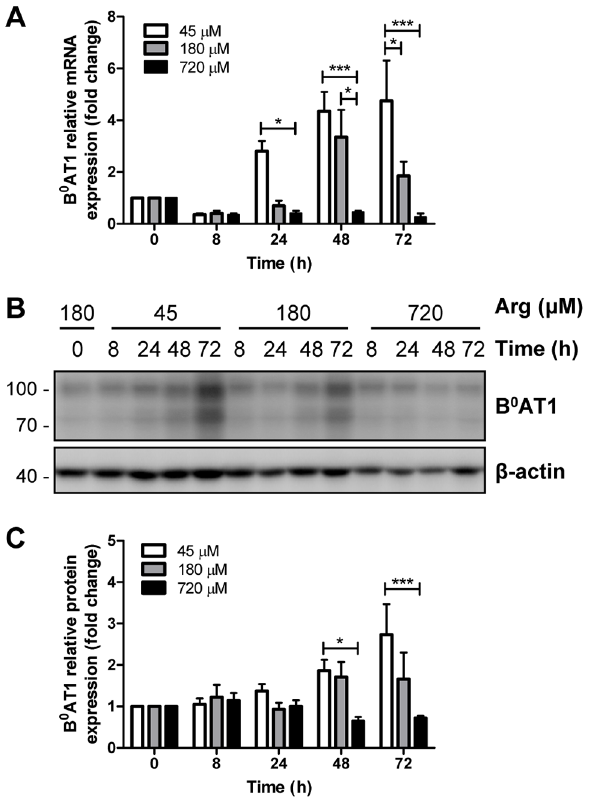
Figure 4. Time course and concentration dependence of effect of arginine on transgene expression. Mycoplasma-infected B 0 AT1- TMEM27 overexpressing MDCK cells were cultivated in arginine-free DMEM supplemented with 45, 180 or 720 m M arginine for the indicated times. A: Real-time PCR quantification of B 0 AT1 mRNA expression. mRNA levels were standardized to b -actin and normalized to time 0. B: Representative Western blotting of B 0 AT1 expression. C: the intensity of B 0 AT1 immunoreactive bands was quantified, standardized to b -actin and normalized to 0 h. Data are represented as mean 6 SEM (n=3). Groups were compared by two-way ANOVA followed by Bonferroni post-test; *** p # 0.001, * p # 0.05.